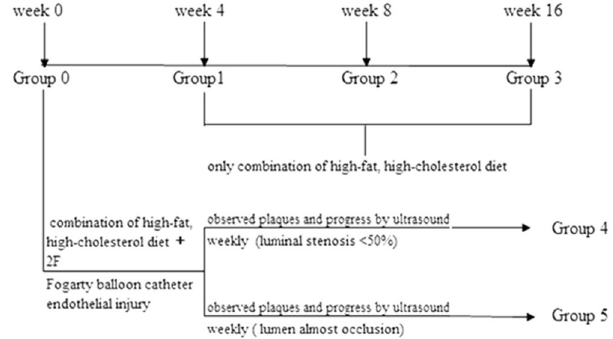
Figure 1. Rabbit model